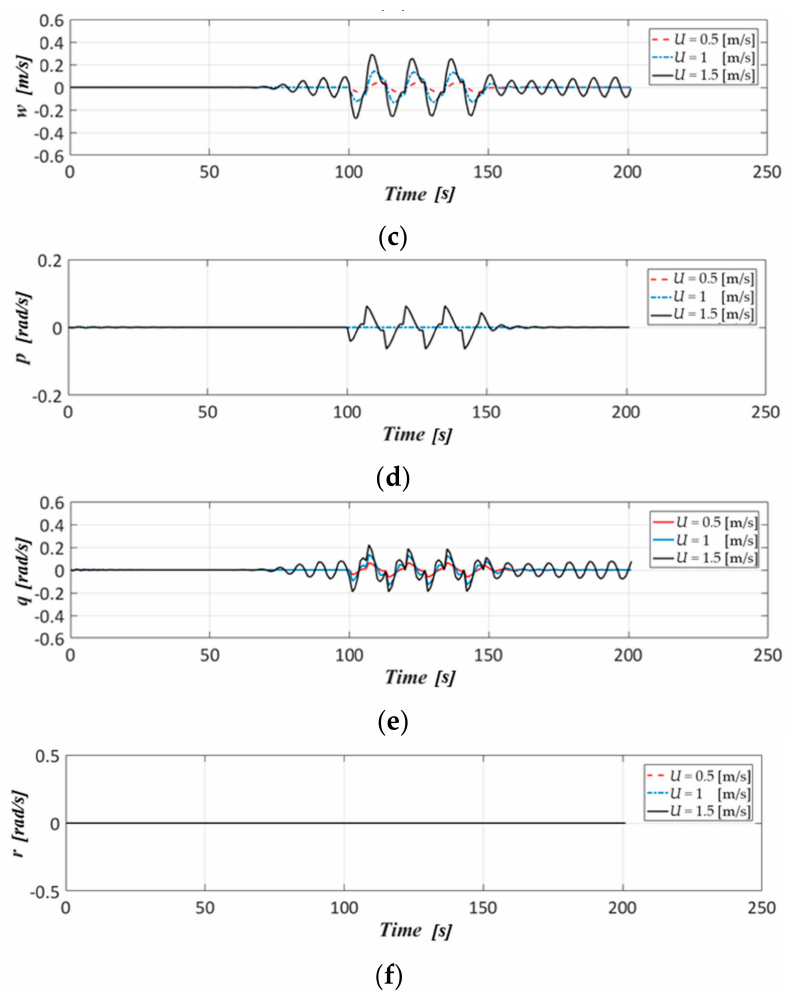
Figure 20. 6-DOF velocity components in the vertical zigzag test at different sailing speeds. ( a ) Surge rate: u [m/s], ( b ) sway rate: v [m/s], ( c ) heave rate: w [m/s], ( d ) roll rate: p [rad/s], ( e ) pitch rate: q [rad/s], and ( f ) yaw rate: r